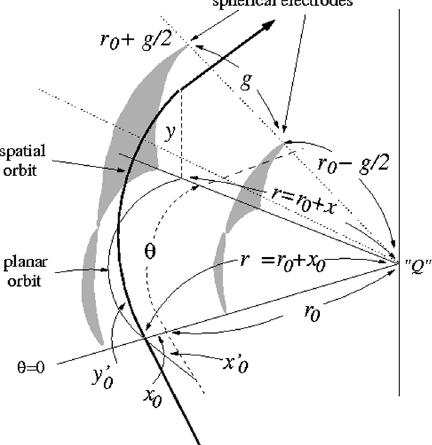
FIG. 1. The bold curve shows a particle orbit passing through a spherical , m ¼ 1 , electrostatic bending element. The shaded surfaces are electrodes and the figure is grossly distorted. The Q shown at the origin is the “ effective point charge ” that would give the same idealized electric field as the electrodes.